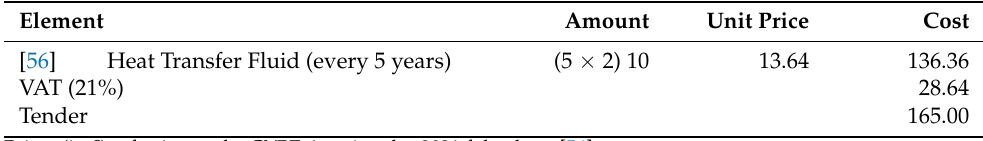
Table 7. Maintenance costs from ST system.